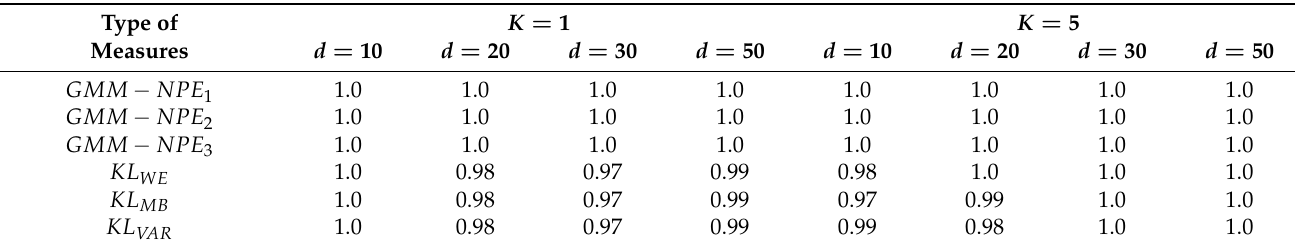
Table 6. Results in the form of recognition accuracy, obtained on the synthetic data: l = 2, t 1 , t 2 ∈ [ 0,5 ] , N = 800, M = 200, m 1 , m 2 =